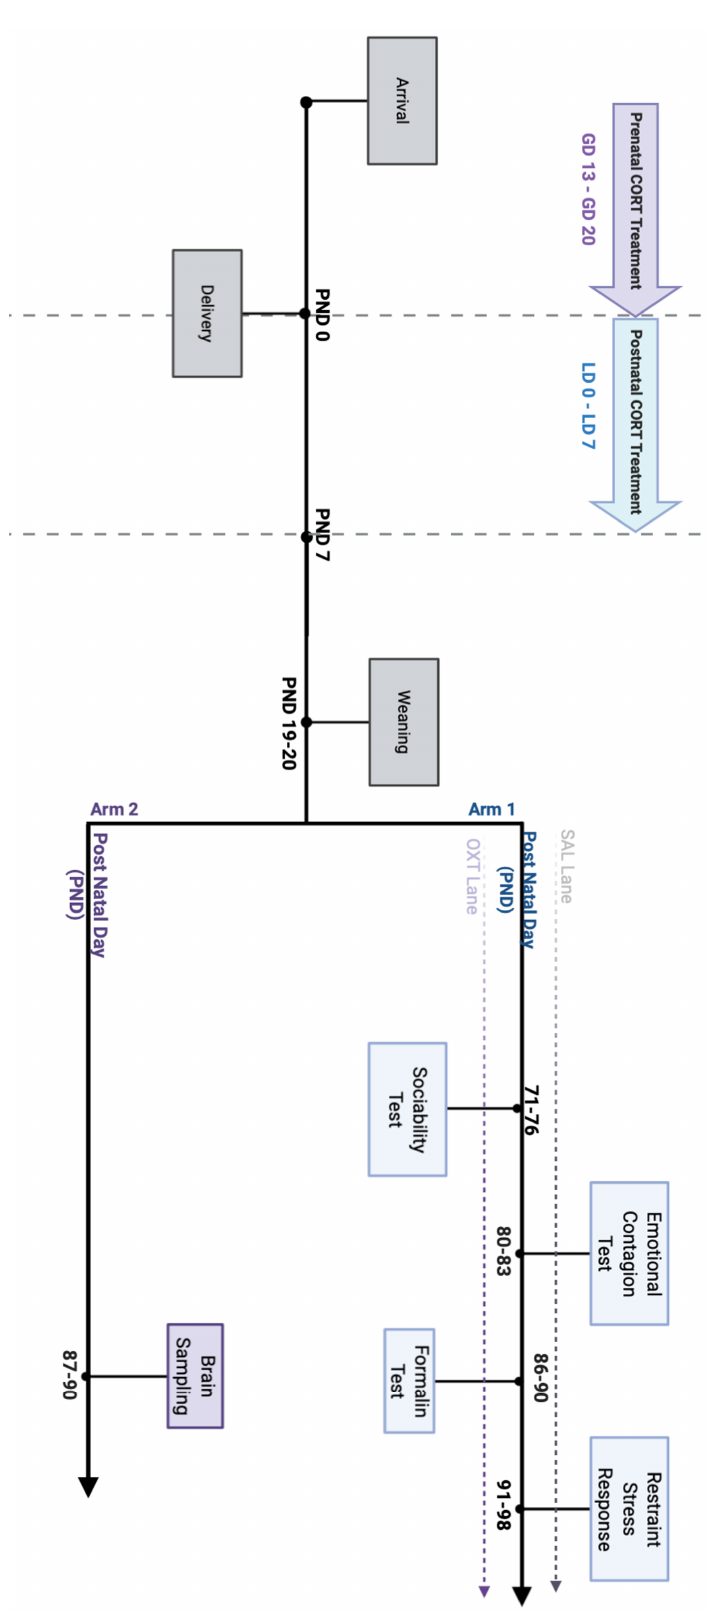
Figure 1. Timeline. Schematic representation of the experimental timeline for all the subjects included in the test battery.